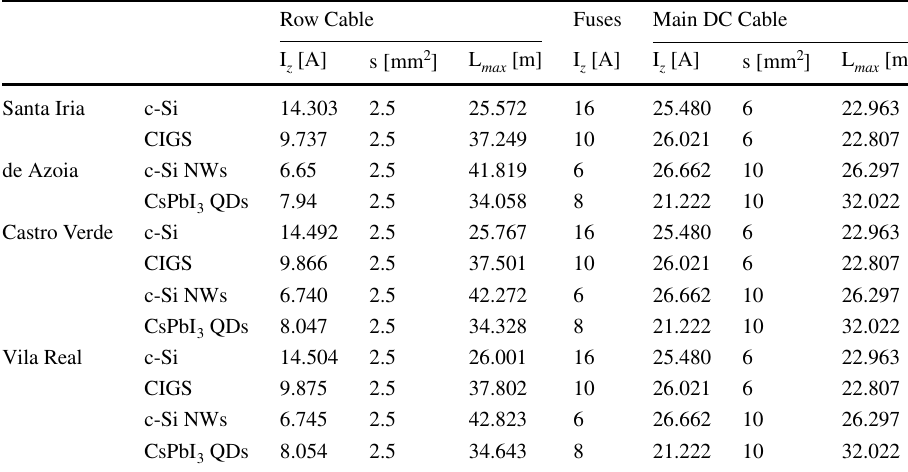
Table 7 DC sizing